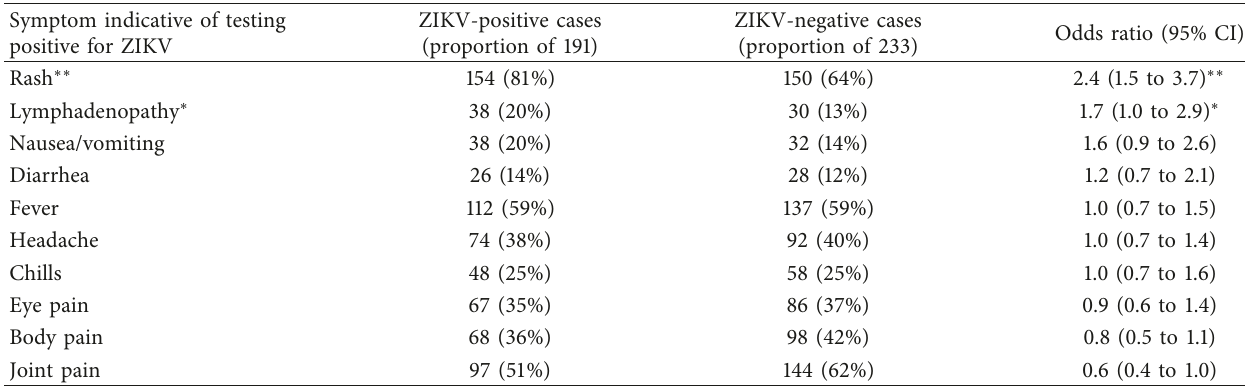
Table 2: Symptoms most commonly reported among symptomatic cases during the 2016 Zika outbreak in Grenada, showing the odds ratio for testing positive or negative with rash as statistically highly significant ( ∗∗ p < 0 . 001) and the odds ratio for lymphadenopathy as statistically significant ( ∗ p < 0 .